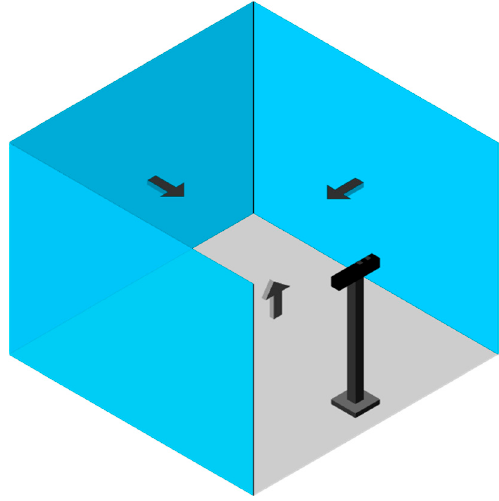
Figure 4. The initial reference vectors.